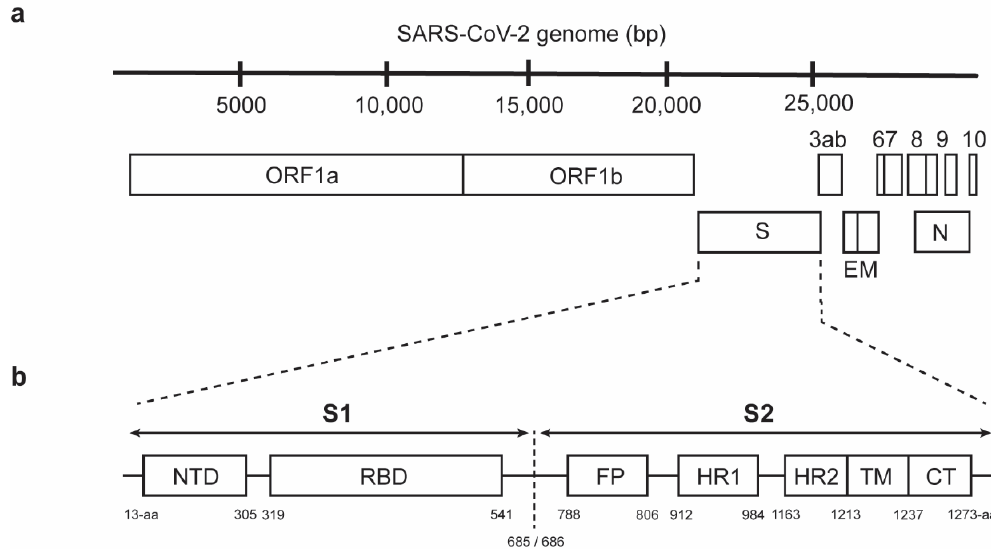
Figure 1. Schematic representation of ( a ) the genome structure (in bp) of severe acute respiratory syndrome coronavirus 2 (SARS-CoV-2) that is causing the coronavirus disease 2019 (COVID-19) pandemic and ( b ) the spike (S) protein (in aa) of SARS-CoV-2, comprising the S1 and S2 subunits. The residue numbers of each region correspond to the position in the S protein. ORF, open reading frame; S, spike; E, envelop; M, membrane; N, nucleocapsid, NTD, N-terminal domain; RBD, receptor binding domain; FP, fusion peptide; HR1, heptad repeat 1; HR2, heptad repeat 2; TM, transmembrane domain; CT, cytoplasmic tail.